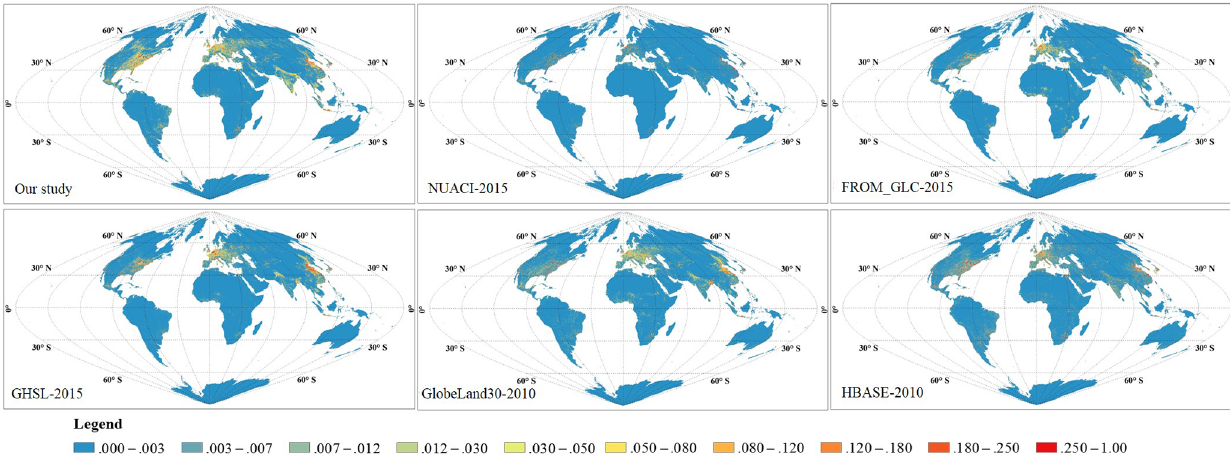
Figure 7. The spatial patterns of six global 30m impervious products after aggregating to the resolution of 0.05 ◦